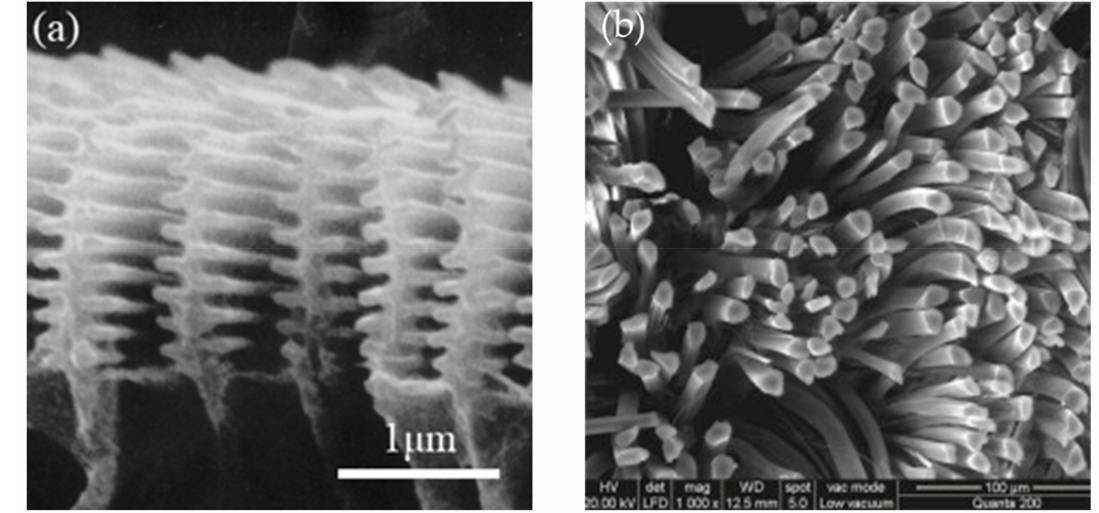
Figure 1. Natural metamaterials. Cross-sectional images of ( a ) the male butterfly Morpho didius [5,6], and ( b ) silk fiber